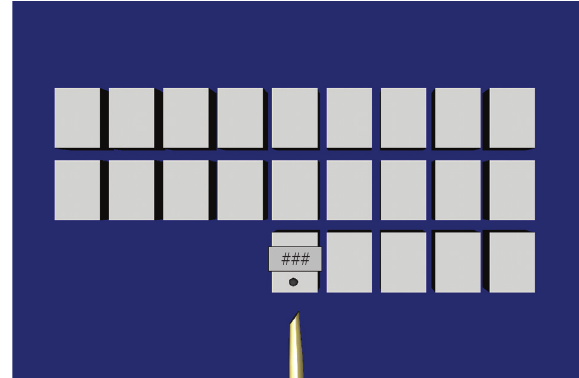
Figure 5: As participants touched each tile it generated vibrations that were felt through the stylus, or it remained still. Simultaneously with the haptic sensation a (congruent, neutral or incongruent) label appeared on the tile. After a judgment was given for a tile it disappeared from the